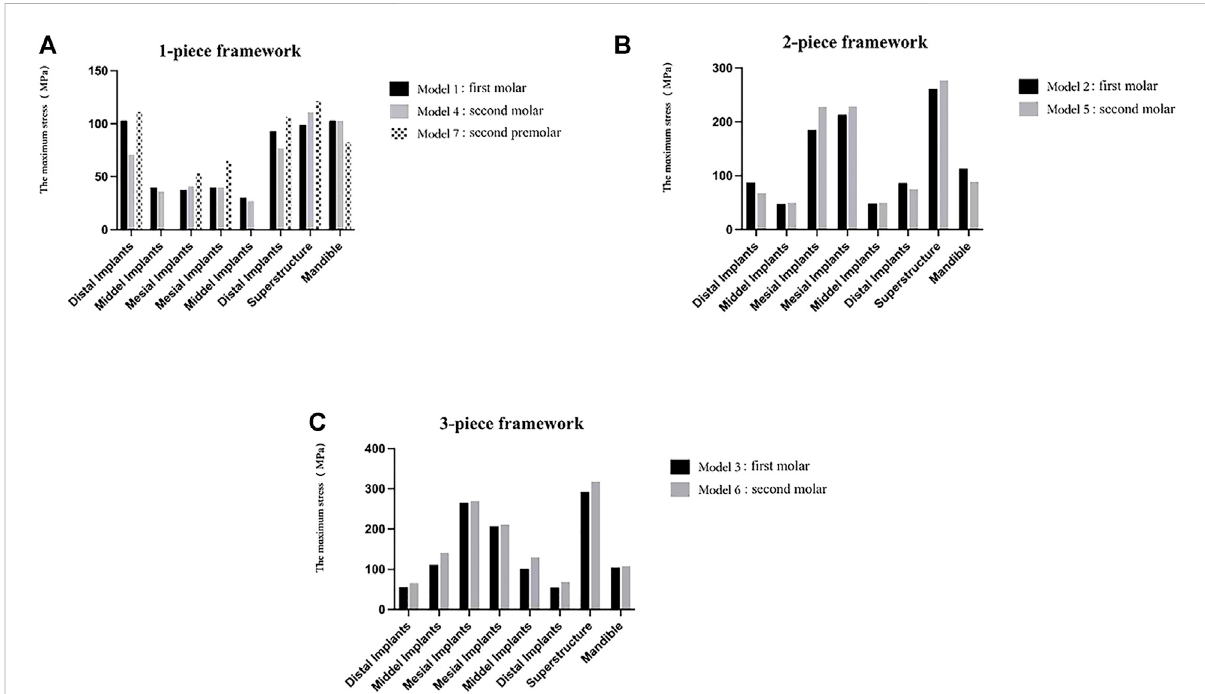
FIGURE 9 Maximum von Mises stresses onthemandible andprostheses withdifferentnumbers andsitesofimplants. In theone-piecesuperstructure (A) , the stress on the prosthesis in model 7 (with cantilever) is the largest; in one- (A) or two-piece frameworks (B) , the stress on the mesial implants and the superstructures increased as the distal implants were more distally located; in the three-piece framework (C) , stress values of the mandible, prostheses, and any implants increased as the distal implants were more distally located.